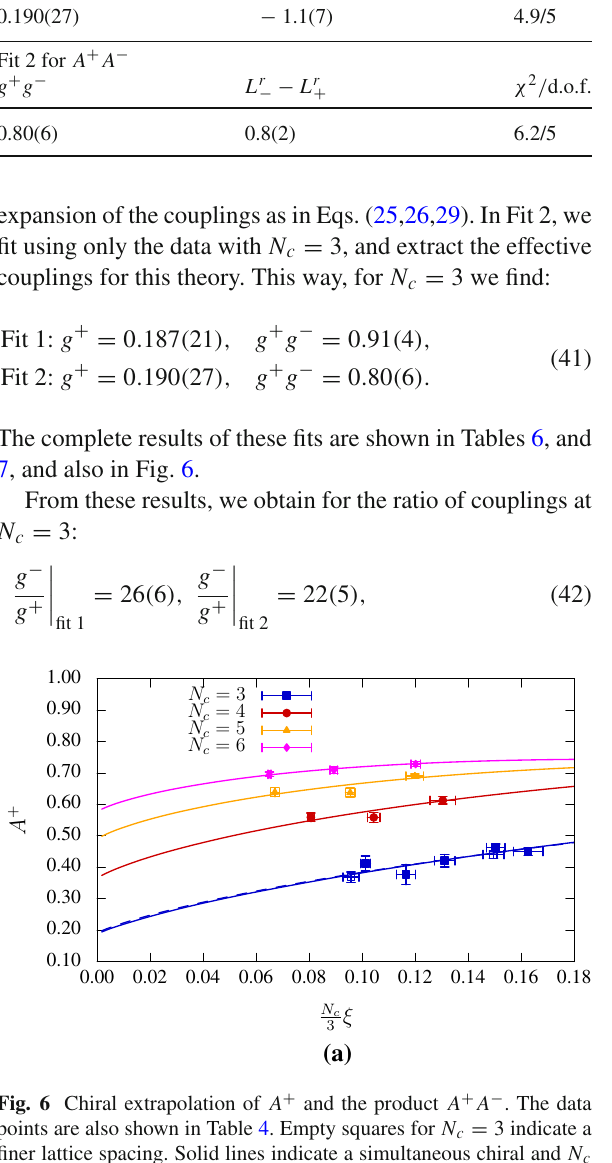
Table 7 Results for Fit 2: the chiral fit at N c = 3 for A + and A + A − . Errors are only statistical